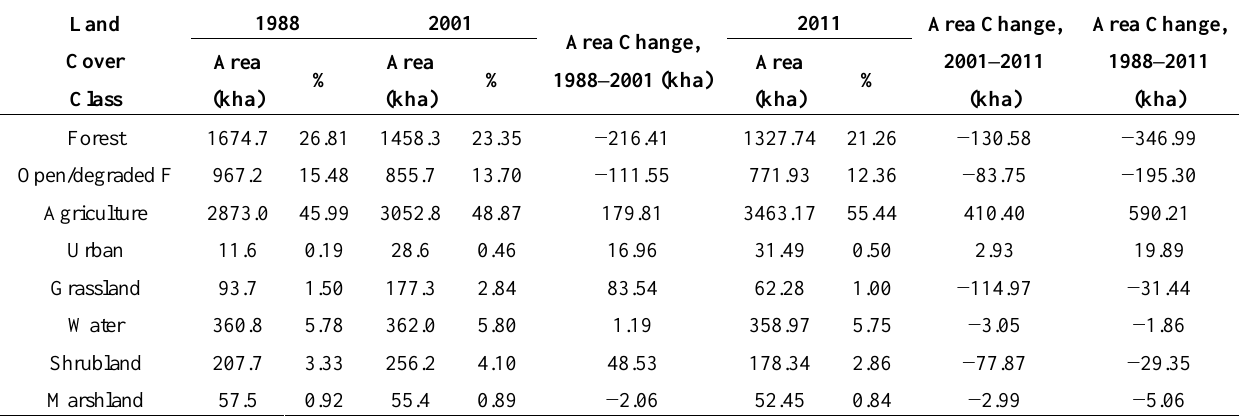
Table 5. Area and proportion of each major class during various periods in the study area (Area: kha, proportion %).